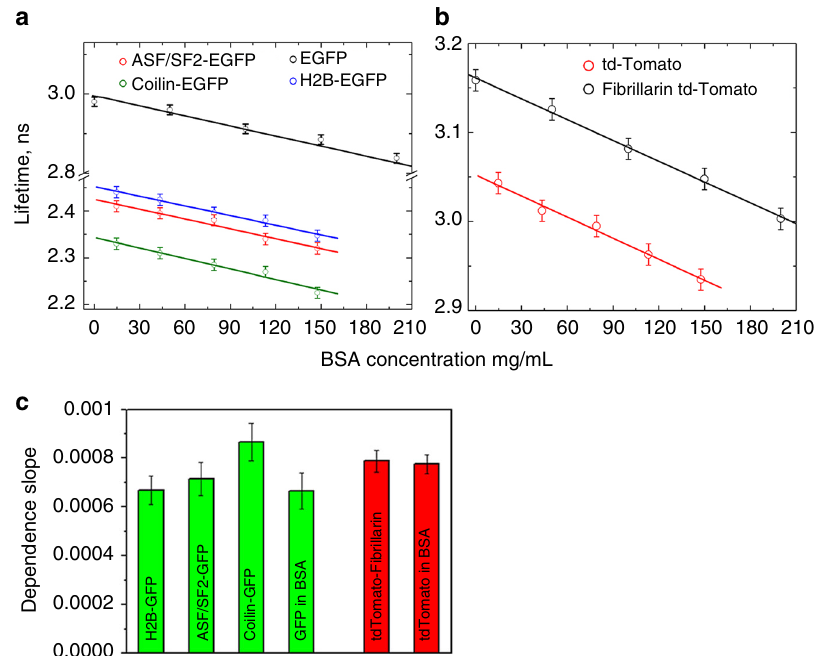
Fig. 1 Calibration of fl uorescent proteins lifetimes in bovine serum albumin solutions. a , b Dependence of fl uorescence lifetimes of EGFP and tdTomato on the concentration of bovine serum albumin (BSA) in solution. c Dependence slopes calculated for plots a and b . Error bars are St. Dev. ( n = 15 for each calibration